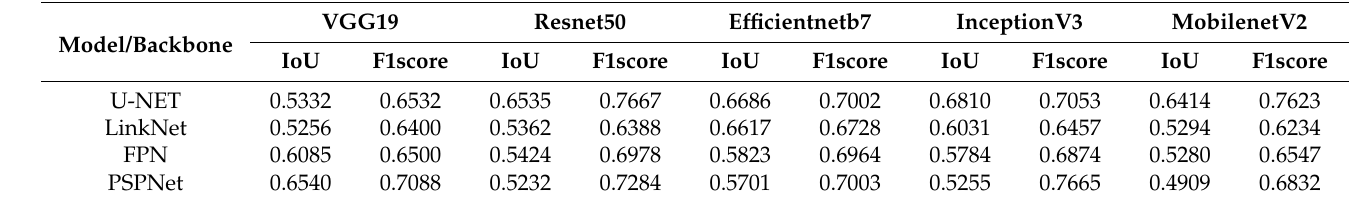
Table 4. Performance evaluation of different backbone architectures for SSM using mean IoU value and F1